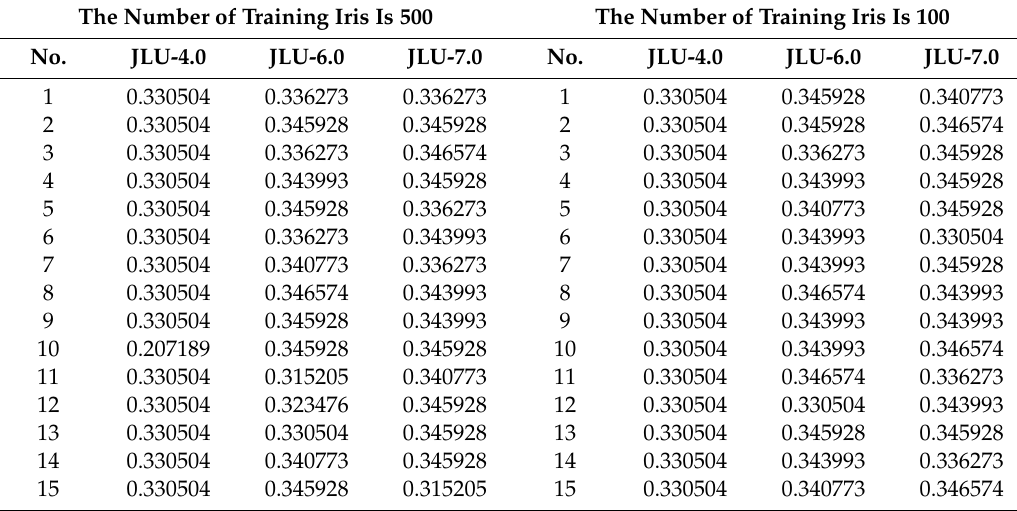
Table 9. The 15 values of the category labels of the three iris libraries.